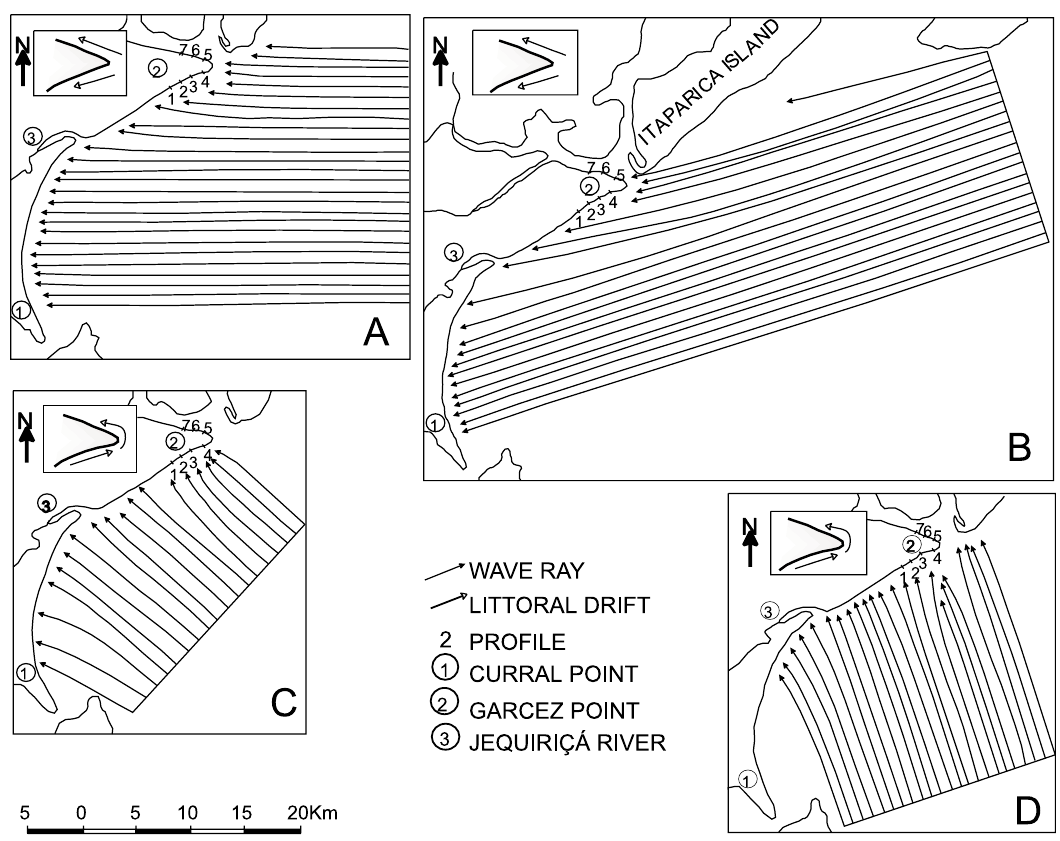
Fig. 3 – Refraction diagrams for waves with a period of 5 sec., from E(A) and ENE(B), and a period of 6,5 sec., from SE(C) and SSE(D). Inserts show the directions of longshore drifts induced by the wave fronts at Garcez